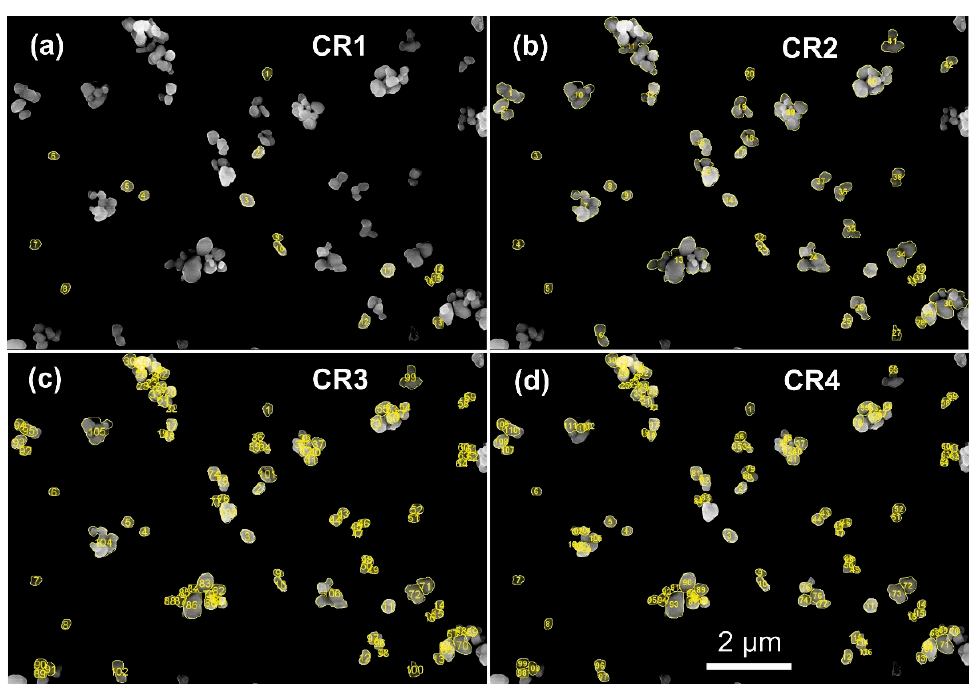
Figure 7. SEM image of titanium oxide particles prepared on a silicon substrate with the particles marked according to the applied counting rule ( a ) CR1: 16 particles, ( b ) CR2: 42 particles, ( c ) CR3: 106 particles, and ( d ) CR4: 116 particles. Counted particles have been given a yellow border. See Figures S4–S6 for the corresponding particle size distributions.